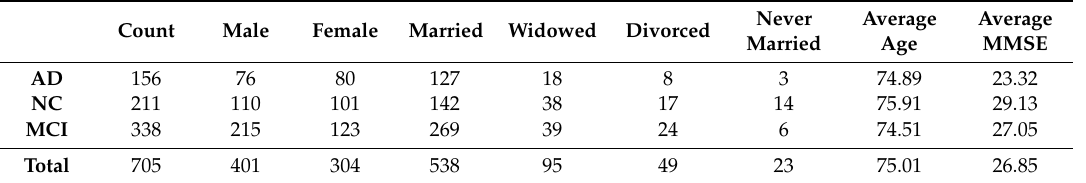
Table 1. Summary of demographic data of patients and subjects. AD: Alzheimer’s disease; MCI: mild cognitive impairment; MMSE: Mini-Mental State Examination; NC: normal